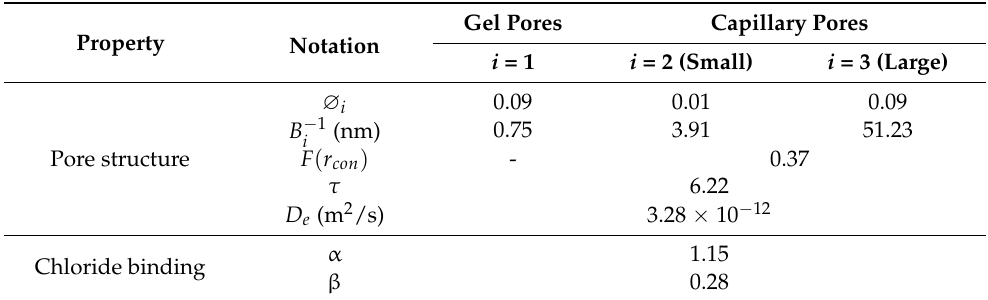
Table 4. Assumed properties for numerical solution of chloride penetration in concrete